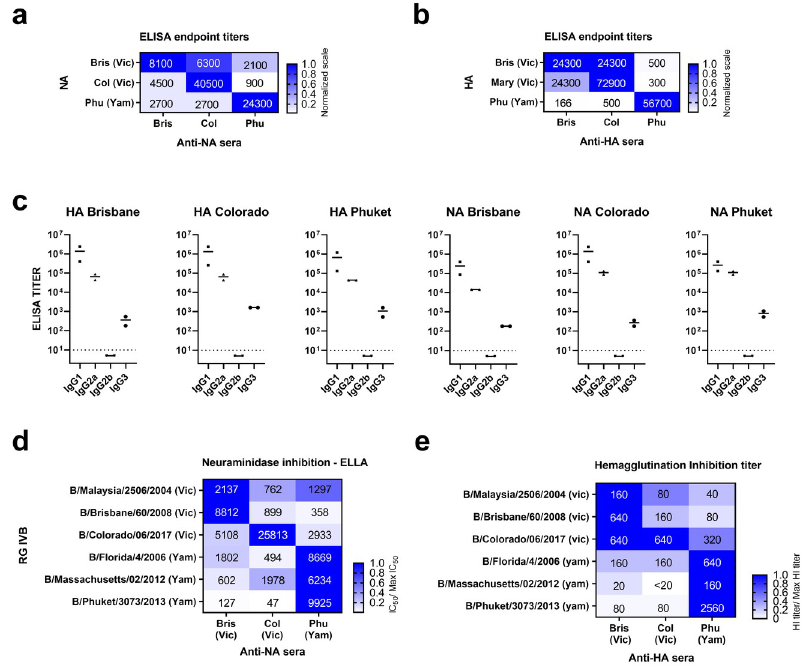
Fig 1. Characterization of anti-NA and anti-HA immune sera. (a) tetNA-specific endpoint IgG titers were determined by ELISA against recombinant tetNA (y-axis) in pooled sera (x-axis). The titer, averaged from triplicate data, is indicated in the matrix, the blue scale represents normalized values (Titer/highest NA titer against each antigen). (b) HA-specific endpoint IgG titers determined by ELISA against HA components (y-axis) used against pooled sera (x-axis). End point titers are indicated and the blue shade represent the normalized values (Titer/highest NA titer against each antigen). (c) Endpoint IgG subclass titers determined by ELISA against coated homologous recombinant NA or HA immunogen as indicated above each of the graphs. Each data point represents an independent quantification (d). Neuraminidase inhibition determined in ELLA assay using anti-NA sera (x-axis) against the indicated RG IBV strains (y-axis). The values shown are the average IC50 values and the blue shades represent the normalized values (IC50/max IC50 per strain). (e) HI was determined using ether-treated IBV strains (y-axis) and anti-HA sera (x-axis). The values represent endpoint titers and the blue scale the normalized values (HI Titer/ max HI titer per strain).